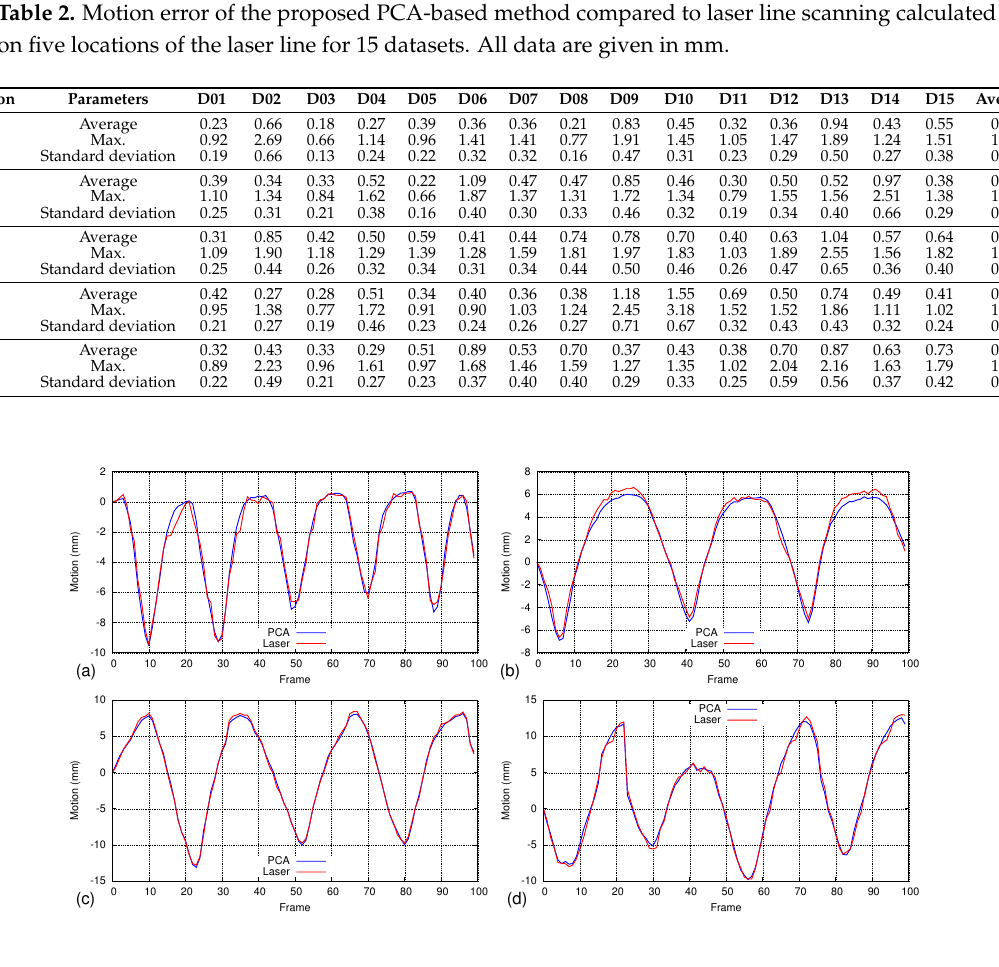
Figure 12. Comparison of respiratory motion measurement using the proposed method (PCA) and laser line scanning. Measurements are taken from different places on the projected laser line. The 101st frame of the dataset is selected as the reference frame, and we measure the motion of remaining frames with respect to it until the 200th frame. Graphs ( a – d ) show the motion measurement results of four different